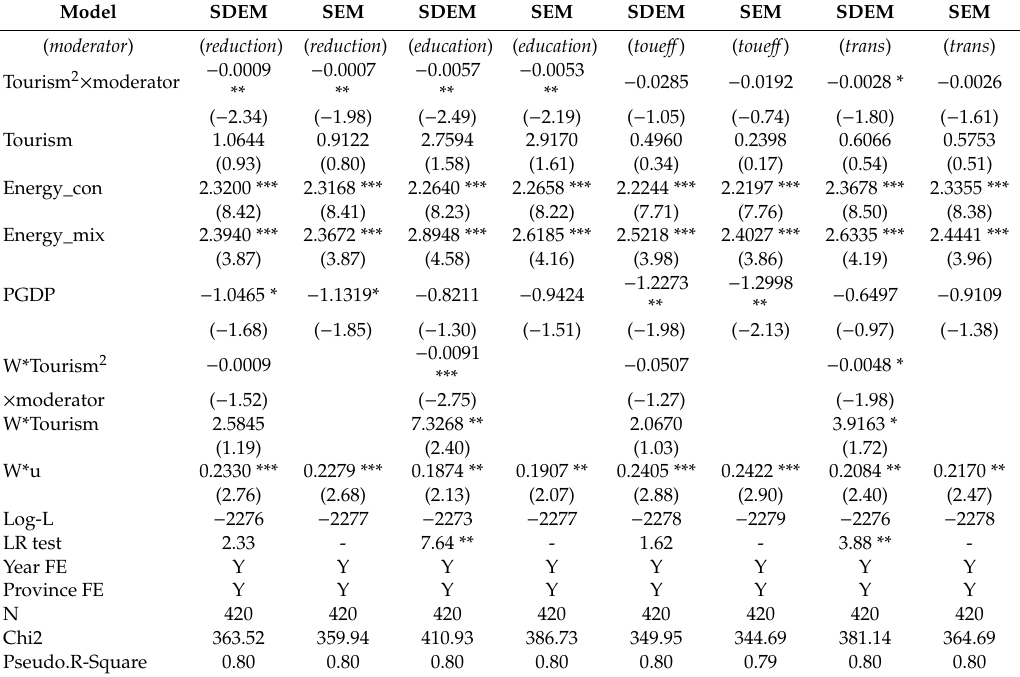
Table 4. Estimation results of the moderating e ff